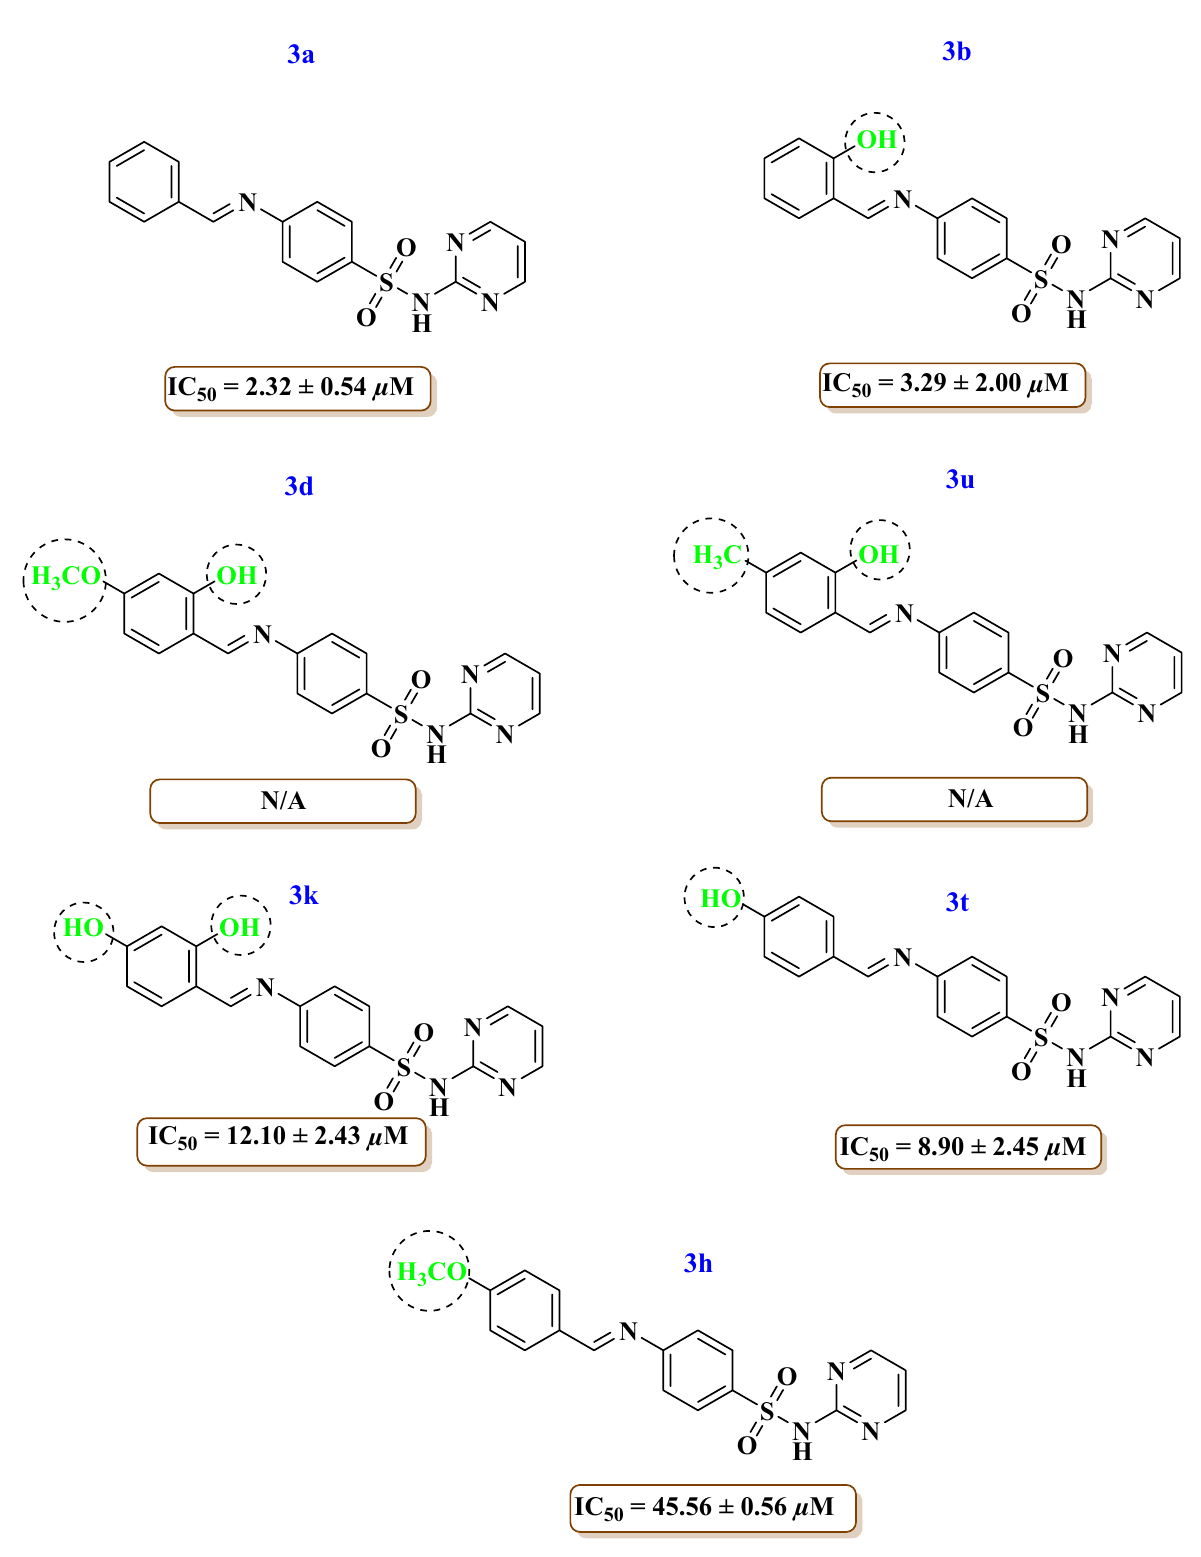
Figure 4. Structure–activity relationship of compounds 3a, 3b, 3d, 3h, 3k, 3t,